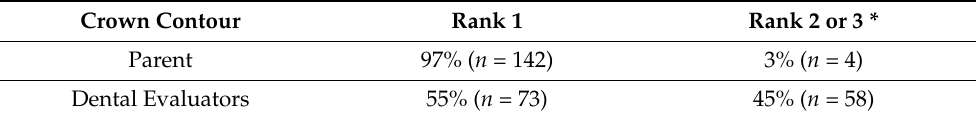
Table 4. Crown contour rank by parents and dental evaluators.